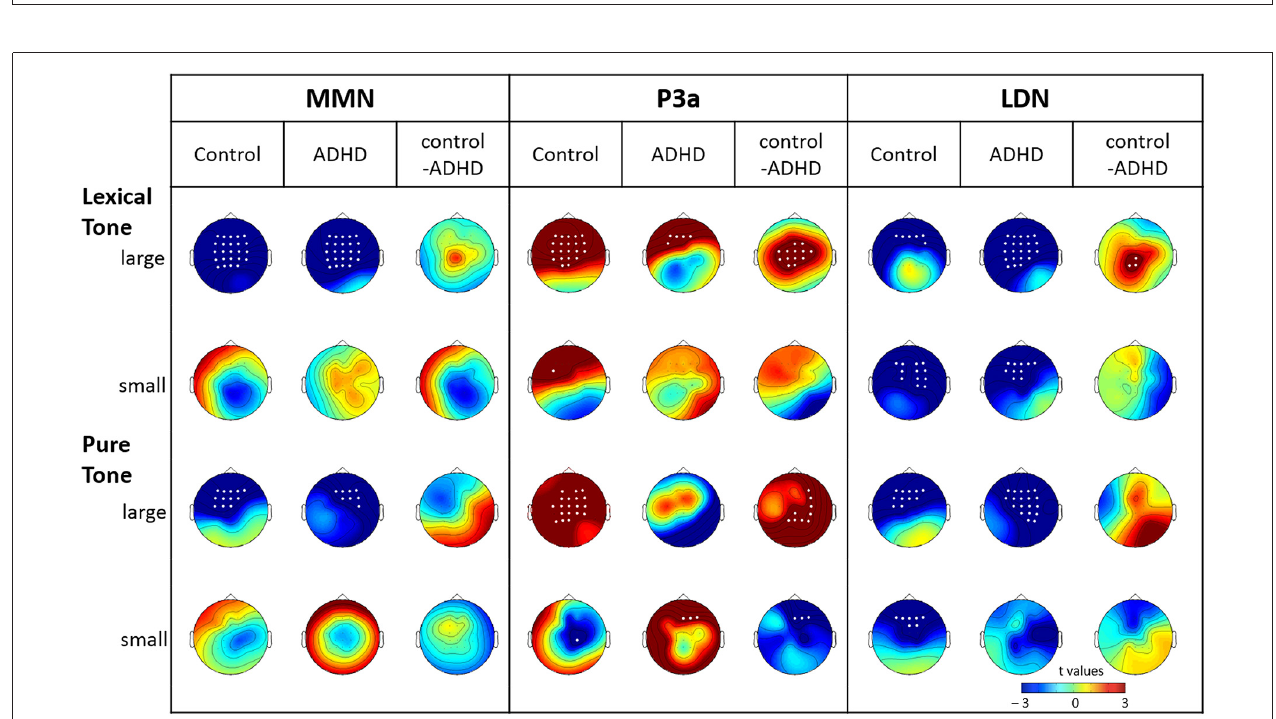
FIGURE 5 | Topographic maps for the significance of mismatch negativity (MMN), P3a, and late discriminative negativity (LDN) ( t -value) elicited by large and small deviant lexical tones and pure tones and the